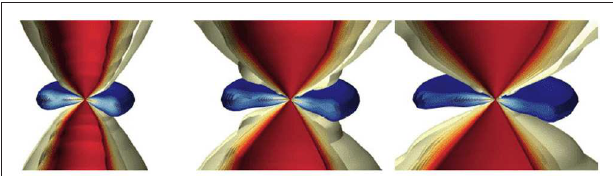
FIGURE 11 | Massive star formation and radiation feedback from jets and radiation fields. From left to right: accretion disk and protostellar outflow at times t = 20, 30, and 40 kyr of evolution. From Kuiper and Hosokawa (2018) reproduced with permission c ESO. (cid:13)